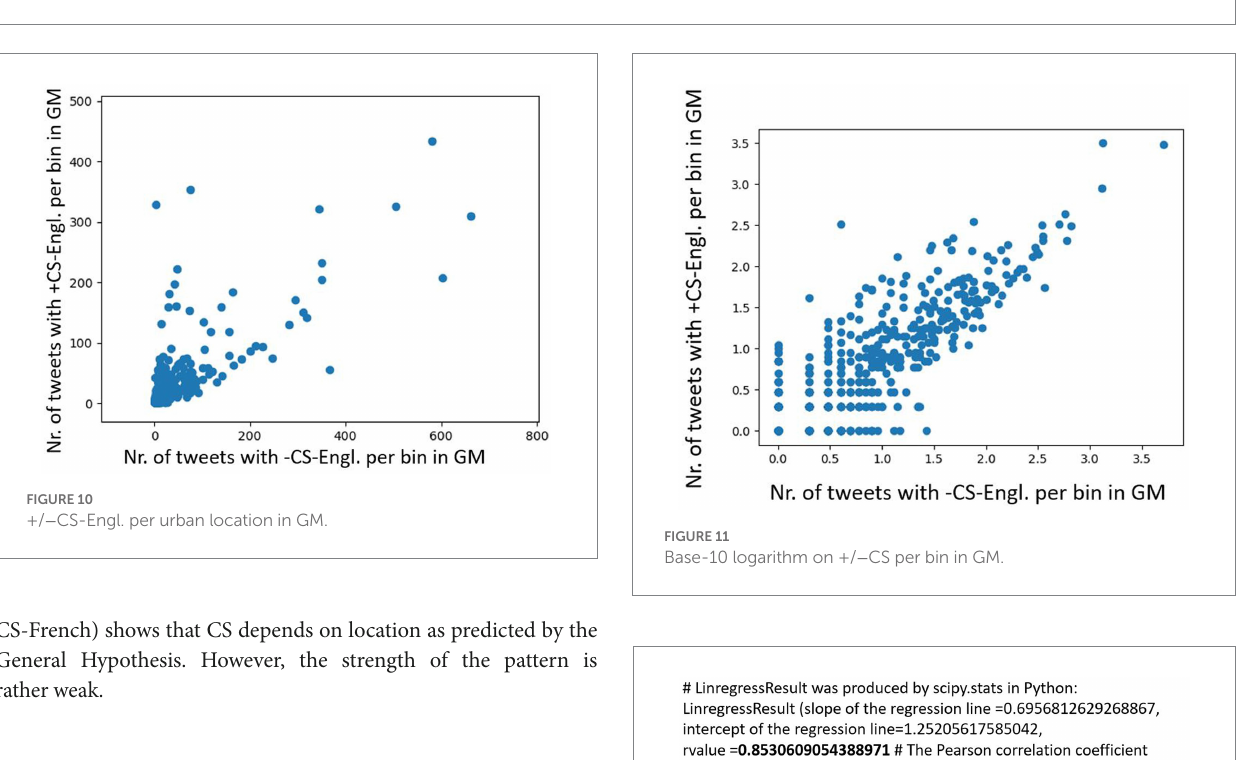
FIGURE 9 Comparison of +/ − CS-Engl. in Greater Montreal. ( A , left): full list. ( B , right): self-referring items. Base map and data from OpenStreetMap and OpenStreetMap Foundation under the Open Database License.